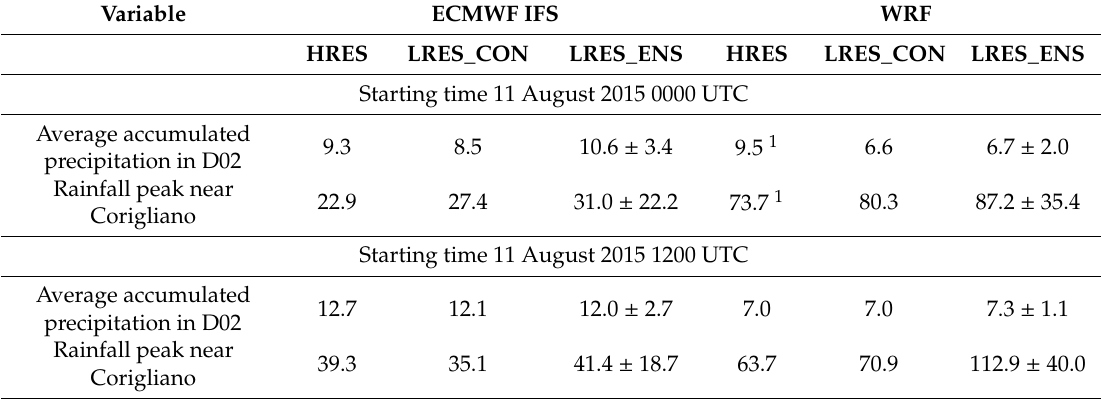
Table 2. Average accumulated precipitation in the innermost domain and rainfall peak in an 80